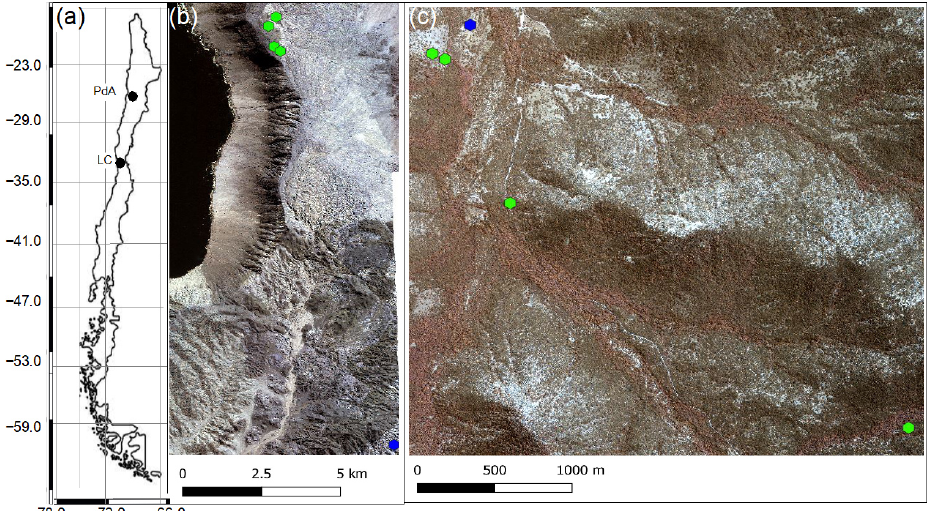
Figure 1. Location of the cameras and climate stations on which this study was based. Black points show the location of the research sites in Chile. The green points represent the camera plots, and the blue points the climate stations: (a) Location of study sites in Chile: PdA stands for Pan de Azúcar, and LC stands for La Campana. (b) Study setup in Pan de Azúcar. (c) Study setup at LC. The background images in (b) and (c) are orthophotos created from WorldView-2 data from 19 July 2019. For exact the latitude and longitude values, see Table A2. Table 1. The most common burrowing animals in the study sites. The list includes both animal species recorded with our motion-activated wildlife traps and those from the literature review (Übernickel et al. 2021; Cerquiera 1985; Jimenéz et al. 1992; Munoz-Pedreros et al. 2018); “ × ” indicates at which site the species can be found. Order Family Species Common name Site PdA